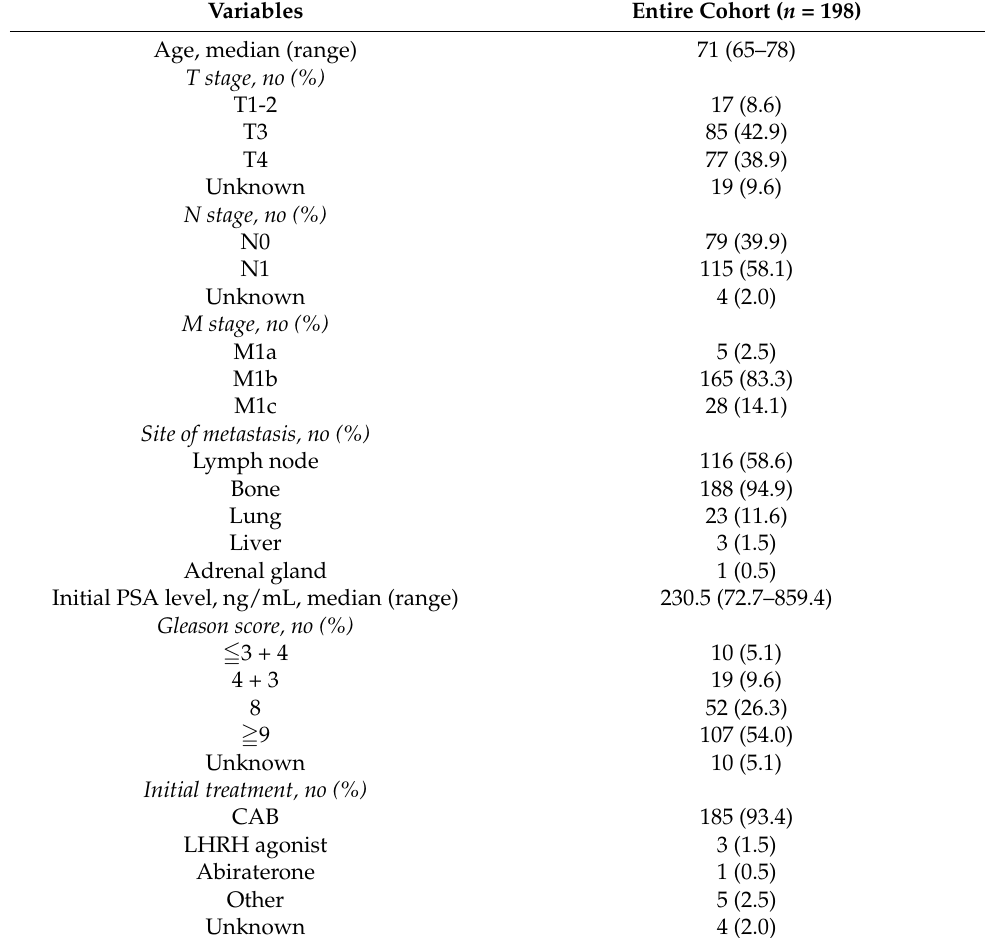
Table 1. Patient characteristics.